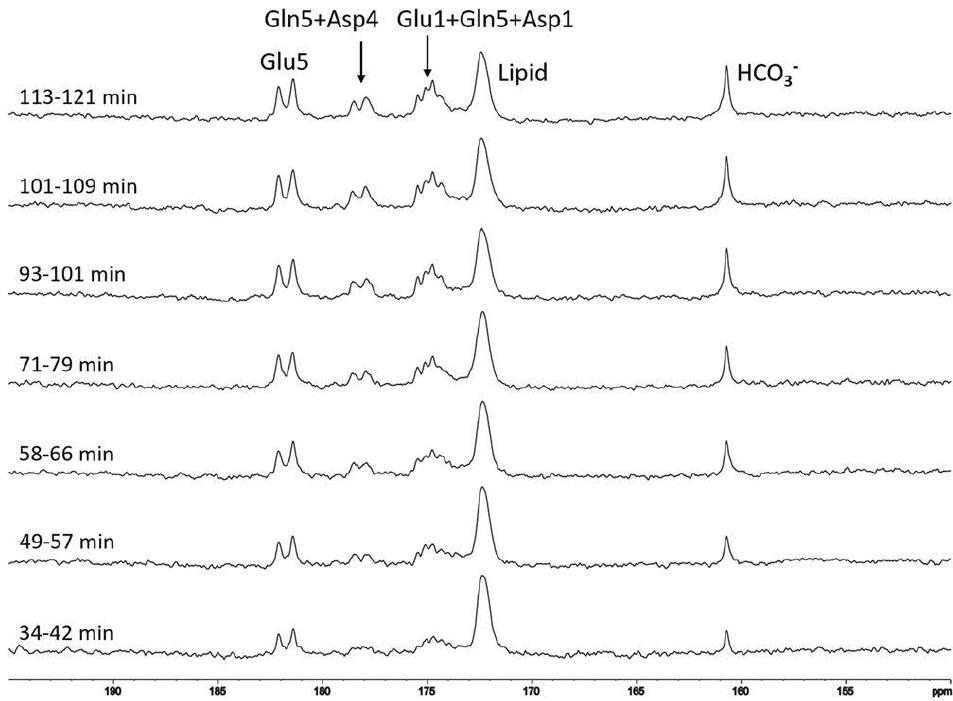
Figure 3. A typical time-course of control spectra acquired from a single subject after oral administration of [U- 13 C 6 ] glucose without proton decoupling. Each spectrum was acquired with recycle delay = 30 s, spectral width = 8 kHz, number of data points = 2048, number of averages = 12, and line broadening = 8 Hz. The time interval indicates the beginning and end of acquisition following oral glucose intake. Lipid: carboxylic carbons of natural abundance lipids (172.5 ppm), Glu5: glutamate C5 (182.0 ppm), Glu1: glutamate C1 (175.4 ppm), Gln5: glutamine C5 (178.5 ppm), Gln1: glutamine C1 (174.8 ppm), Asp4: aspartate C4 (178.3 ppm), Asp1: aspartate C1 (175.0 ppm) (reprinted from ref. [43]. https://creativecommons.org/licenses/by/4.0/).